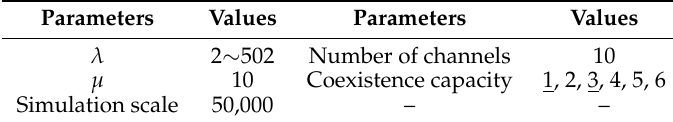
Table 3. Parameter Table.